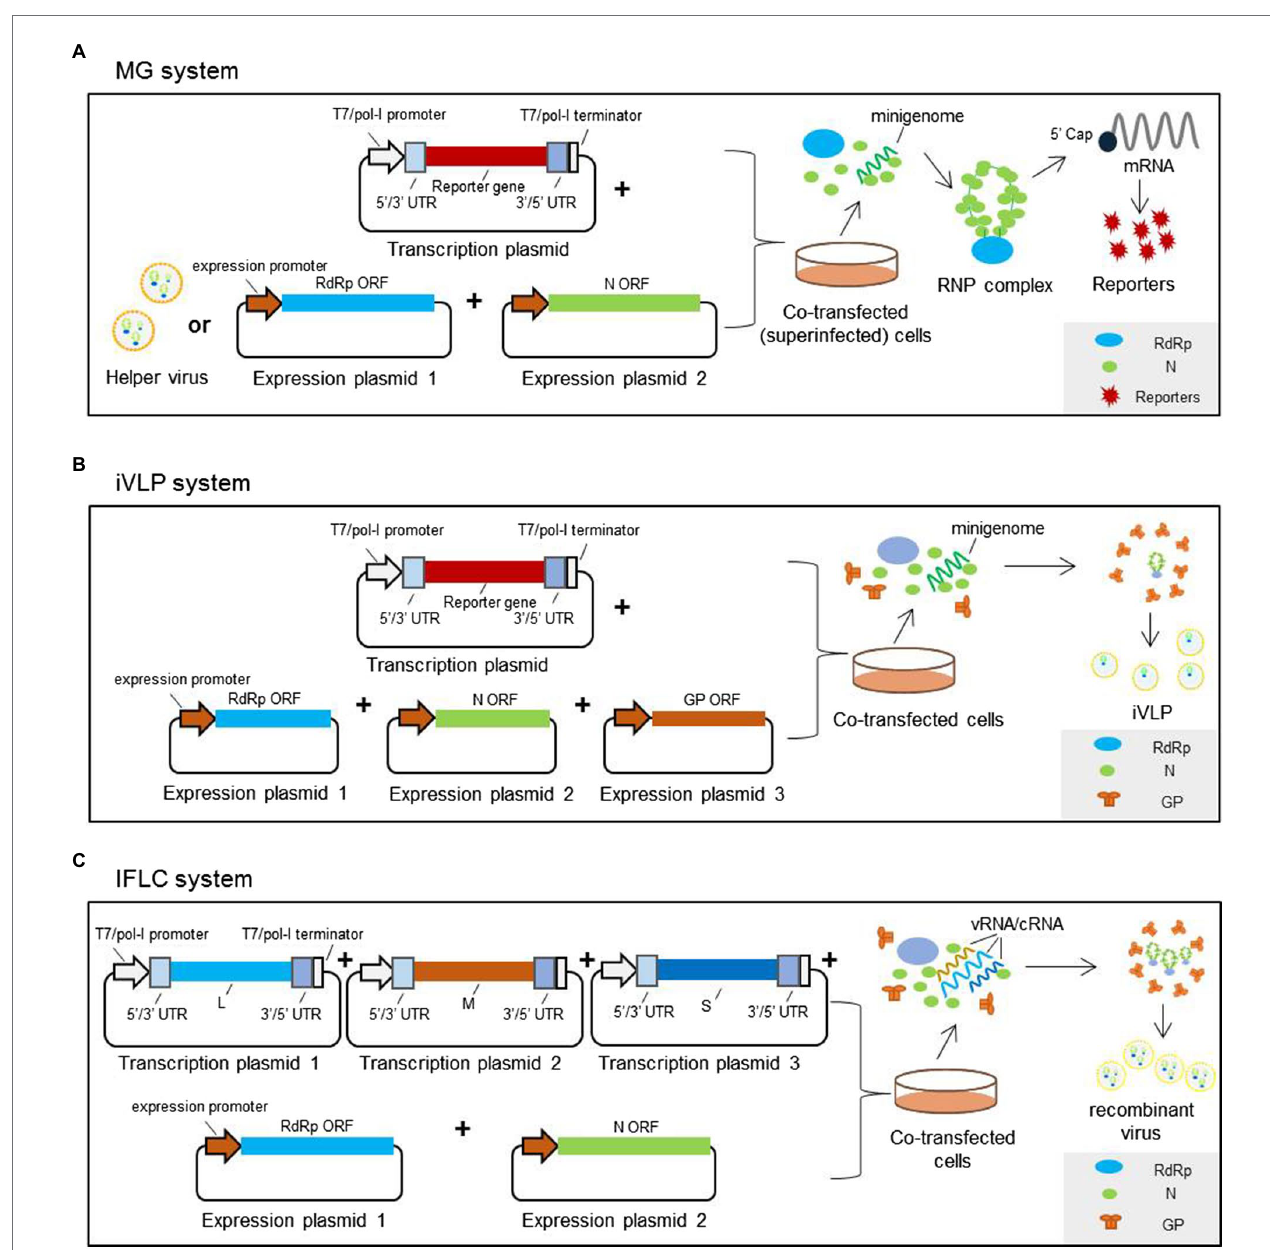
FIGURE 3 | Reverse genetics systems established for typical three-segmented bunyaviruses. (A) Minigenome system based on plasmid transfection mainly consisting of expression plasmids encoding RdRp, N, and T7 or pol-I-driven transcription plasmid to express virus-like genome or antigenome RNA. The transcription plasmids are constructed by inserting the reporter-encoding gene flanked by viral UTRs into a T7 or pol-I promoter-driven vector in sense or antisense orientation. The expression plasmids are constructed by inserting the RdRp- or N-encoding gene into an expression vector. While in a minigenome system with helper virus, the RdRp and N are provided by the authentic wild-type virus instead of the expression plasmids. After co-transfection of the plasmid mix, the functional RNP complexes can form, leading to the expression of reporter proteins. (B) The infectious virus-like particle system is constructed based on the minigenome system, in which Gn/Gc proteins are also provided in trans form from expression plasmids to package the functional RNP complexes to form iVLPs. (C) In an IFLC system, after the cells are co-transfected with plasmids to express full-length antigenomic or genomic L, M, and S and plasmids to express RdRp and N, the functional L-, M-, and S-RNP complexes form. The RNP particles are then packaged by glycoproteins to generate infectious recombinant viruses.